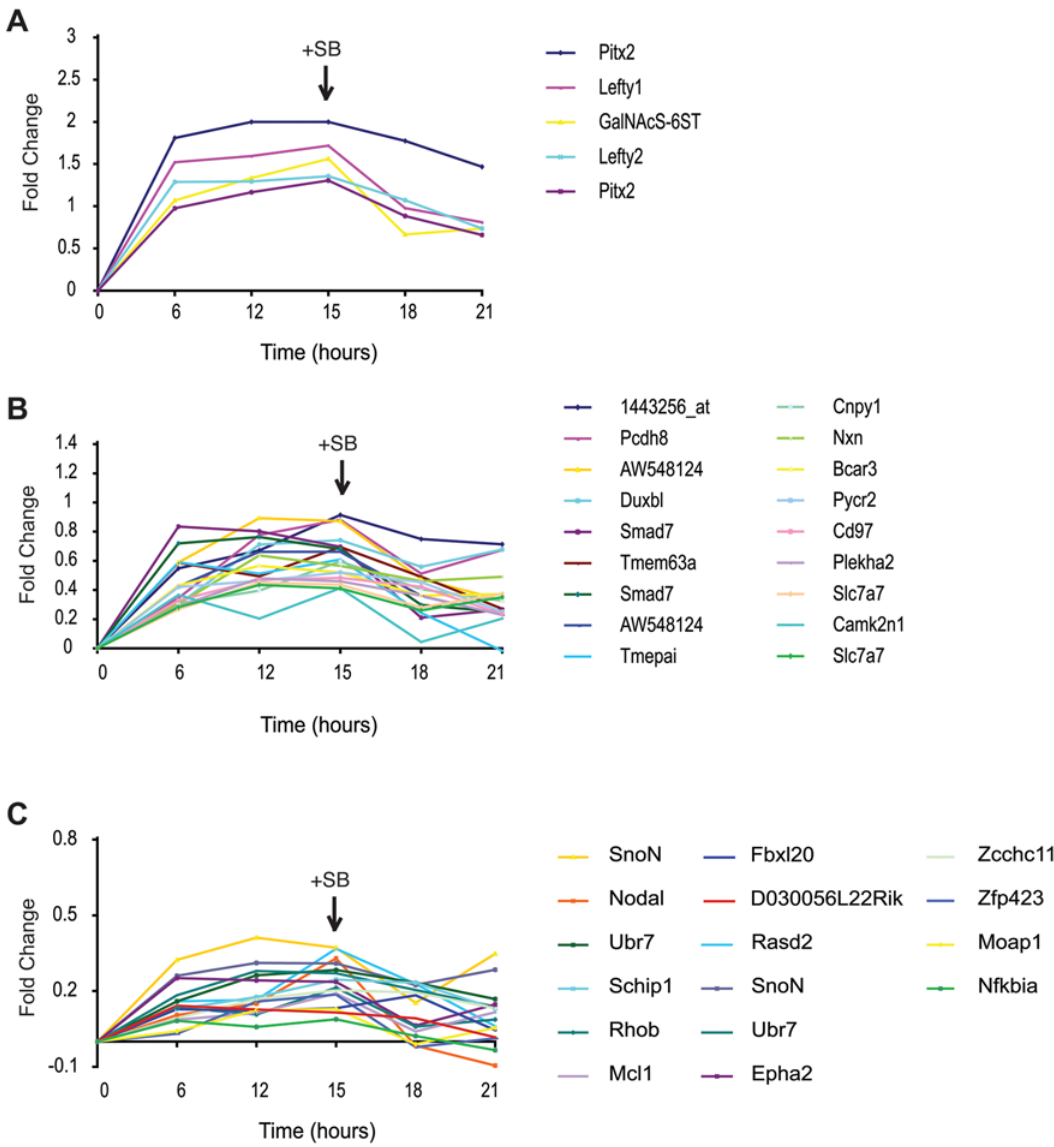
Figure 2. Expression profile of genes responding to the manipulation of Alk4*-Smad2/3 activation in ES cells. Microarray expression analysis of TAG1 ES cells treated sequentially with Dox (activation; 6–15 hours) and SB (inhibition; 18–21 hours). The behaviour of 33 Smad2/3 upregulated genes at different time points (x-axis) during the treatment is represented with trend lines. All samples were normalised to control time points (0) and the relative level of gene expression is presented as the log values of fold change (the y-axis). For all values see Table S1. (A) Trend lines showing the expression profile for genes classified as high response targets ( $ 10-fold upregulation in gene expression at time point 15 hours). (B) Trend lines showing the expression profile of a sub-set of medium response genes, which increases by $ 2.5- to , 10-fold. (C) Trend lines for a subset of low sensitivity response genes, which are upregulated by $ 1.2- to , 2.5-fold.